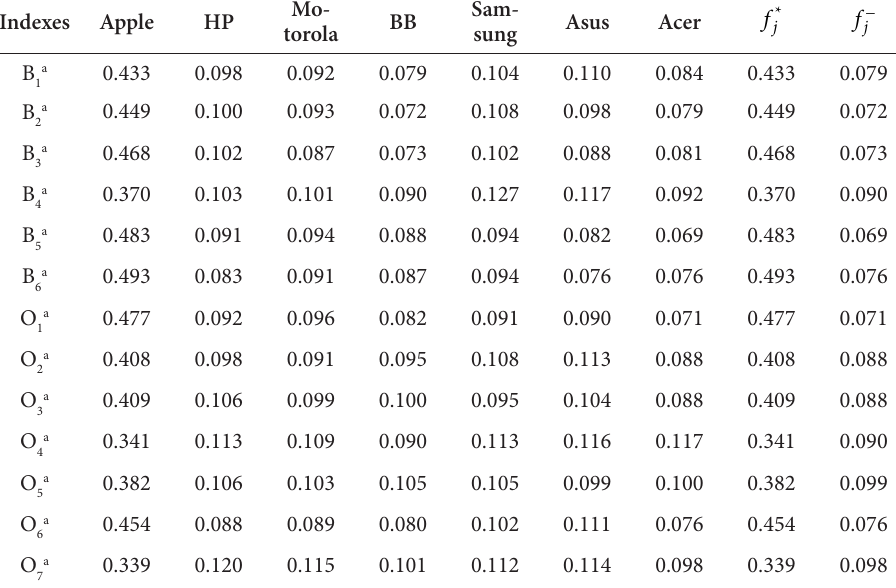
Table A4. Performance matrix with the best value and the worst value by